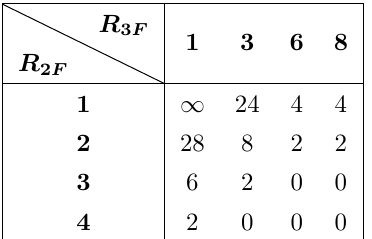
Table 1 . Maximal number of VL fremions with the common mass of 10 TeV for which the SM gauge couplings g and g remain perturbative up to 10 15 GeV . Y 3 2